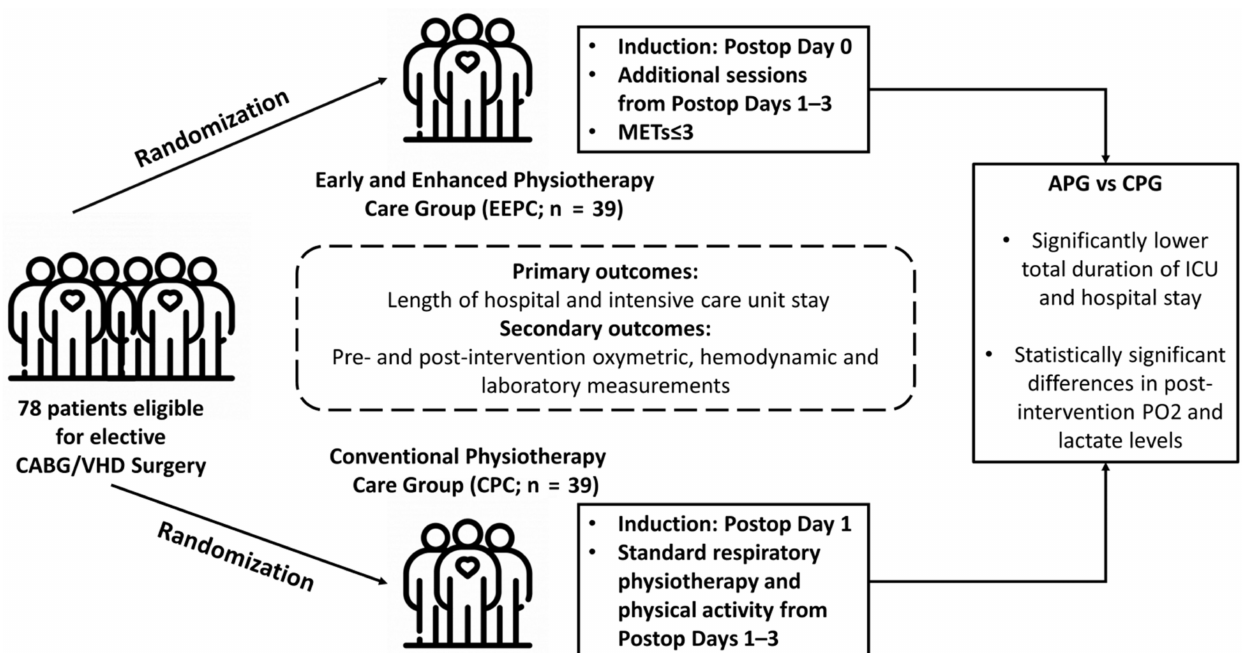
Figure 2. Study protocol and main findings of this randomized-controlled